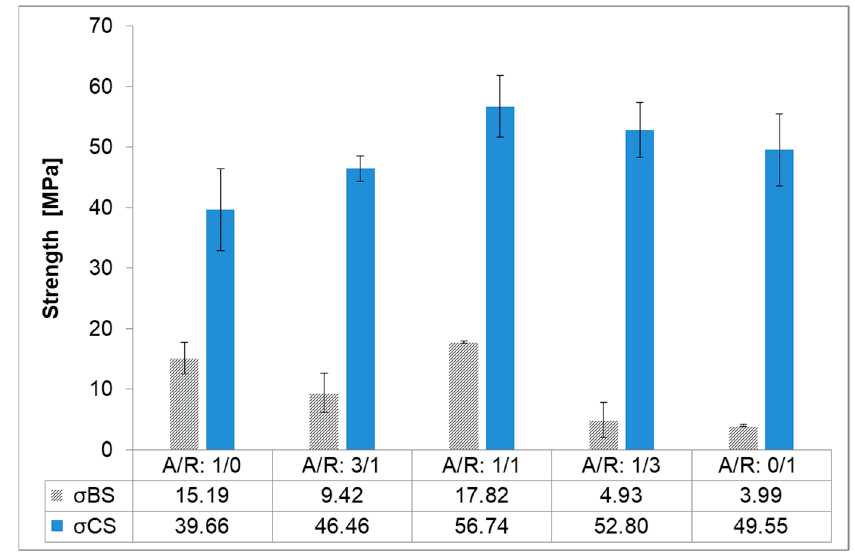
Figure 3. Bending ( σ BS) and compressive strengths ( σ CS) for AA mixtures of A and R slag